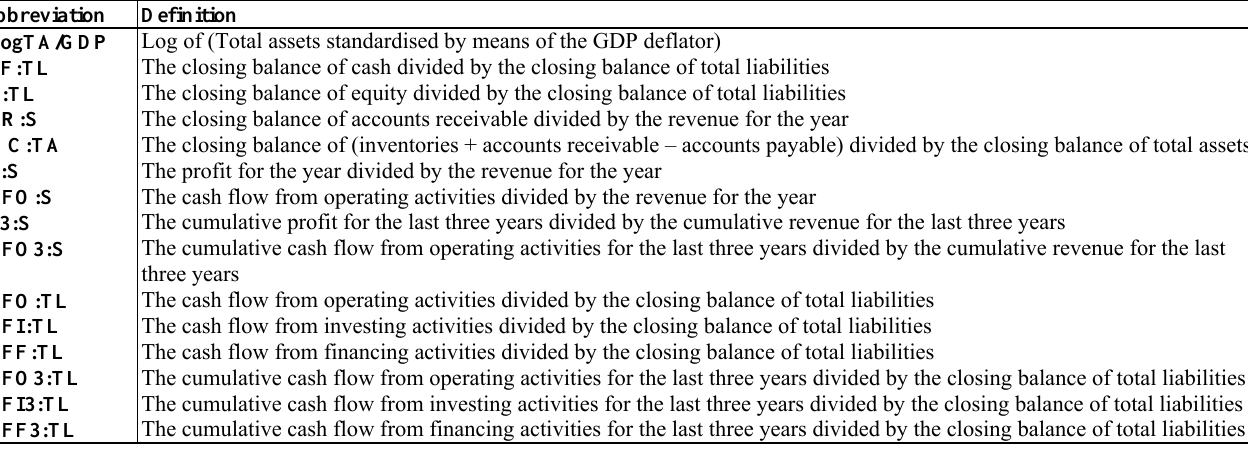
Table 1: Independent variables used in developing failure prediction